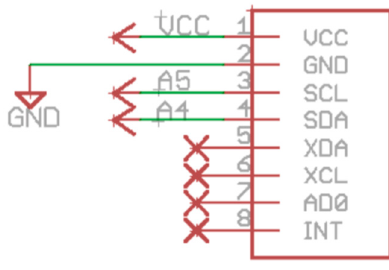
Figure 10. Accelerometer schematic.